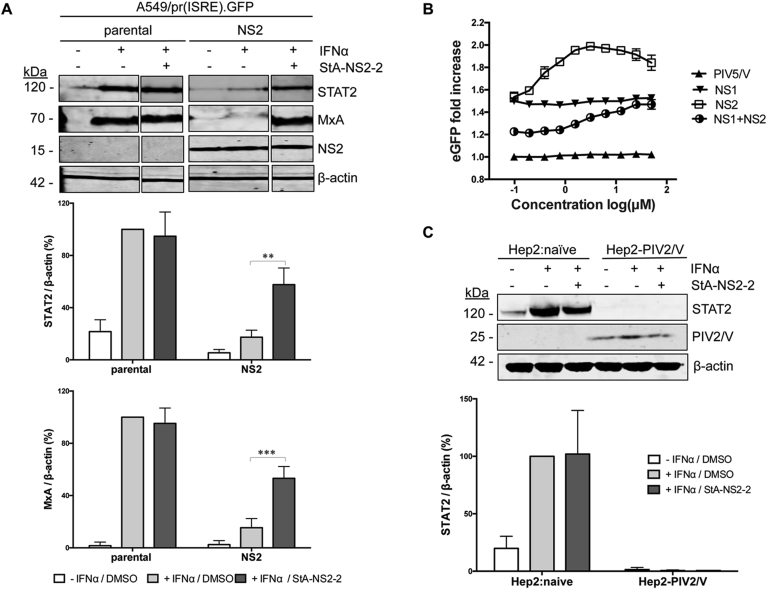
Specificity of hit compound StA-NS2-2. (A) Effect of StA-NS2-2 on MxA and STAT2 levels. A549/pr(ISRE).GFP and A549/pr(ISRE).GFP-NS2 cells were treated with StA-NS2-2 or equivalent volume of DMSO. Two hours post-compound treatment, IFNα was used to activate the IFN signaling pathway. Sixteen hours post-IFNα, cells were lysed, subjected to SDS-PAGE/Western blot, followed by detection with anti-STAT2, anti-MxA, anti-myc or anti-actin antibody and IRDye800-conjugated secondary antibody. Bands were visualized using an Odyssey near-infrared scanner, followed by quantification of % STAT2 and % MxA relative to β-actin. Data shown represents mean values from 3 independent experiments; error bars = SD. Statistical significance was assessed using two-way ANOVA with Turkey's multiple comparison test to compare effect of StA-NS2-2 on STAT2 or MxA levels in αIFN-treated A549/(ISRE).GFP-NS2 cells; ***, p < 0.0005, **, p < 0.005. (B) StA-NS2-2 activity is specific to RSV NS2 and not unrelated viral IFN antagonists RSV NS1 or PIV5 V. A549/pr(ISRE).GFP derivatives expressing RSV NS2, RSV NS1, RSV NS1+NS2 or PIV5 V were treated with StA-NS2-2 using 10-point dose-response curve (two-fold serial dilution series 50–0.1 μM). Two hours post-compound treatment, IFNα treatment activated the IFN signaling pathway. Forty-eight hours post-IFNα treatment, eGFP expression was measured and fold-increase calculated. Data shown represents mean values (n = 4 replicates; error bars = SD) and is representative of at least 3 independent experiments. (C) StA-NS2-2 activity is specific to RSV NS2 and not PIV2 V protein. Hep2 and Hep2-PIV2/V cell-lines were treated with StA-NS2-2 or equivalent volume of DMSO. Two hours post-compound treatment, IFNα was used to activate the IFN signaling pathway. Sixteen hours post-IFNα treatment, cells were lysed, subjected to SDS-PAGE/Western blot, followed by detection with anti-STAT2, anti-V5 or anti-actin antibody and IRDye800-conjugated secondary antibody. Bands were visualized using an Odyssey near-infrared scanner, followed by quantification of % STAT2 relative to β-actin. Data shown represents mean values from 3 independent experiments; error bars = SD.